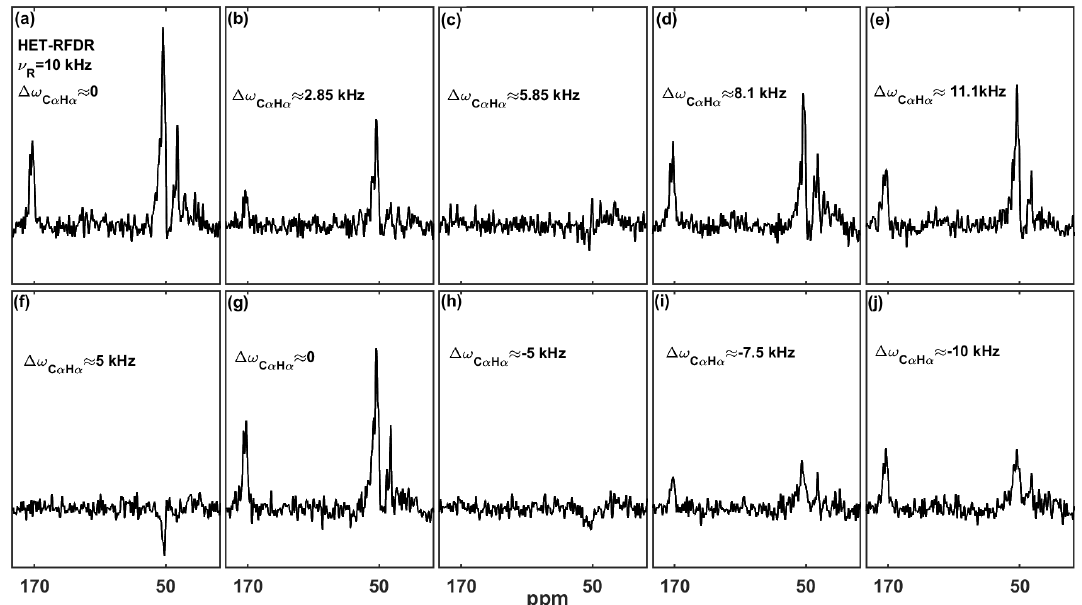
Figure 3. The influence of the carbon and proton offsets on proton–carbon HET-RFDR polarization transfers at 4.8ms mixing. α -PET- labeled SH3 was used with 10kHz MAS with a 600MHz spectrometer using a 1.3mm probe. The widths of π pulses on proton and carbon channels were 5.8 us and 6.6 us, respectively. For (a–e) the proton carrier frequency was set to 4.6ppm, and carbon carrier frequency was set to 51ppm (a) , 70ppm (b) , 90ppm (c) , 105ppm (d) , and 125ppm (e) . For (f–j) , the carbon carrier frequency was set to 83.66ppm, and the proton carrier frequency was set to 4.6ppm (f) , 12.933ppm (g) , 21.26ppm (h) , 25.43ppm (i) , and 29.6ppm (j) . The indicated offset differences, (cid:49)(cid:127) C α H α = (cid:127) C α − (cid:127) H α , in kilohertz (kHz), were calculated based on typical isotropic chemical shifts of C α (51ppm) and H α (4.6ppm) with a 600MHz spectrometer. The experimental parameters are detailed in Tables 1 and 2 in the Experimental methods section. The 1D HET-RFDR sequence is shown in the Supplement (Fig. S1). XY8 phase cycling was used.